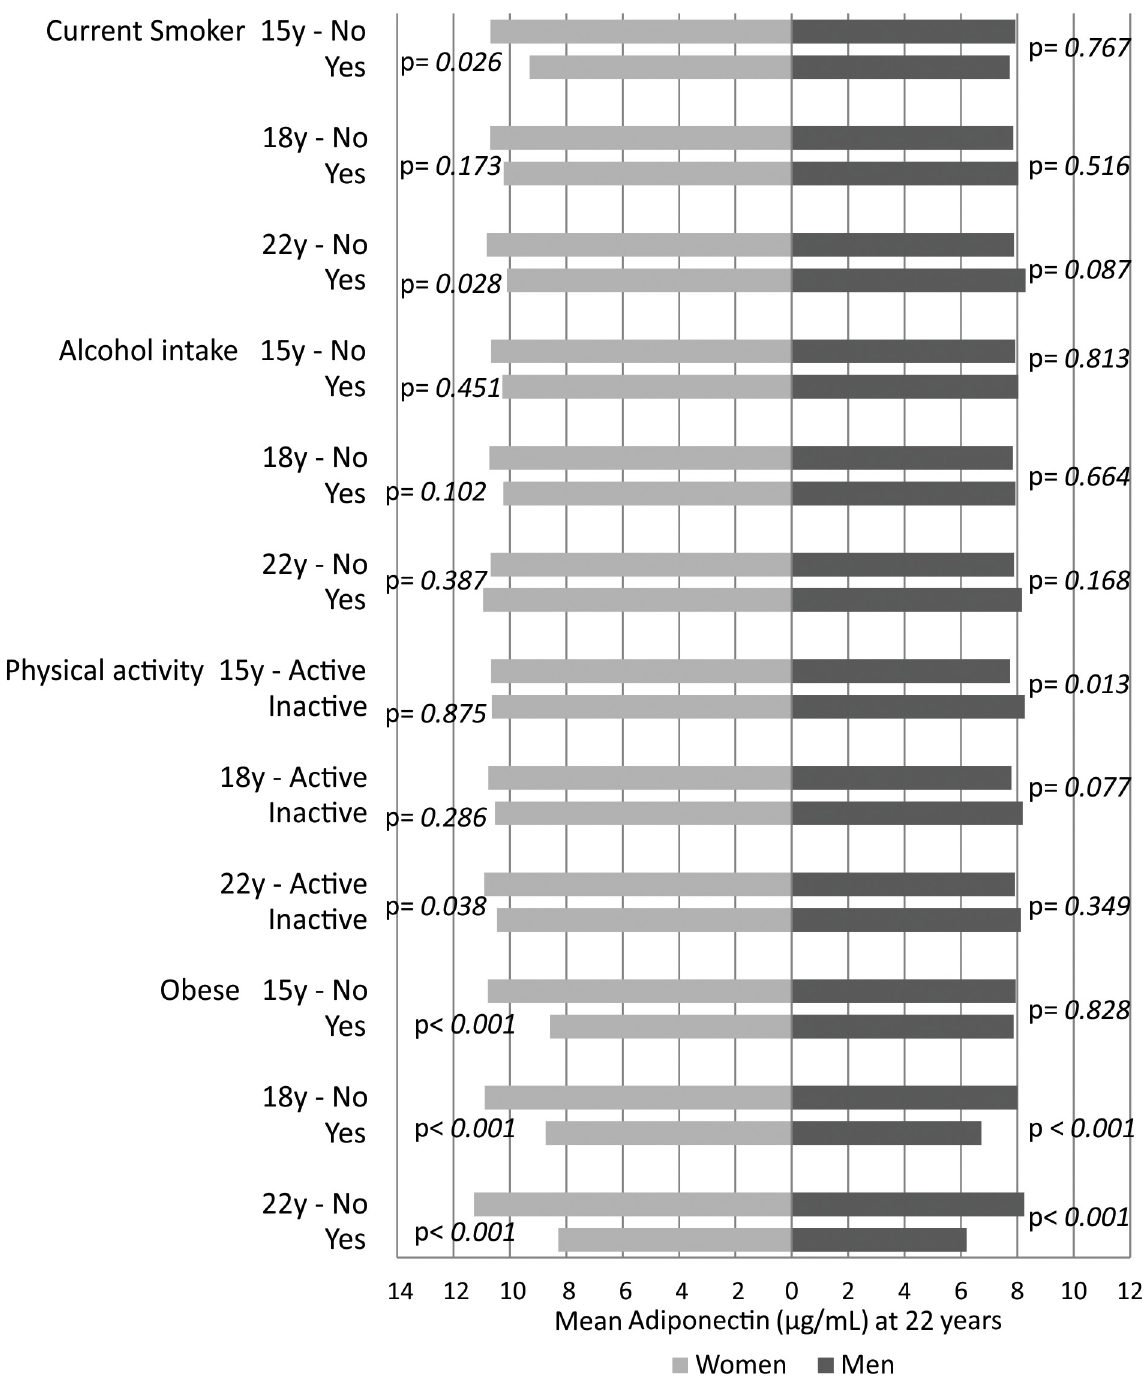
Fig 4. Mean levels of Adiponectin at 22 year follow-up according to smoking, alcohol intake, physical activity and obesity at 15, 18 and 22 years. The 1993 Pelotas Birth Cohort.